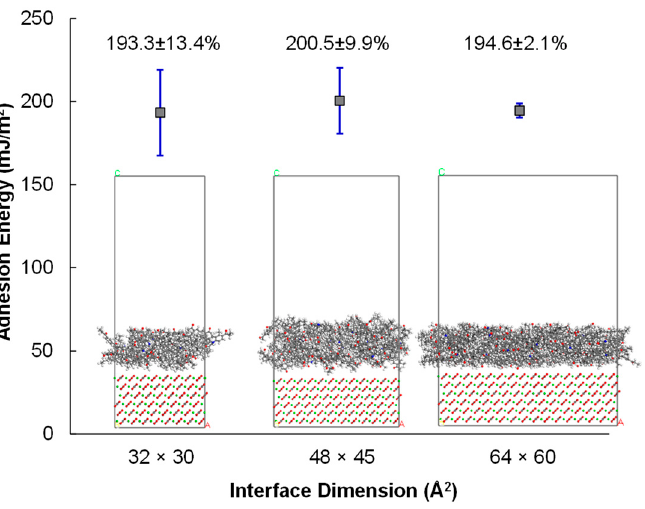
Figure 8. Size effect on the calculation of adhesion energy using the aged asphalt